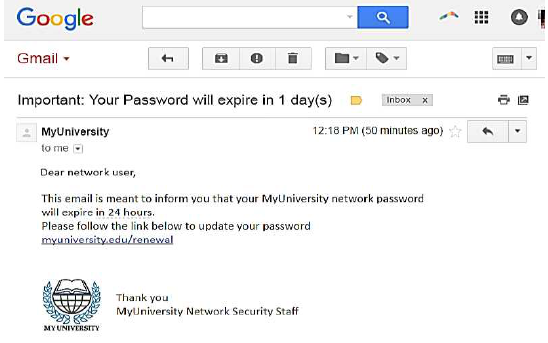
Fig.1 Web spoofing attack performed by attacker Fig.1 depicts how a fake website which